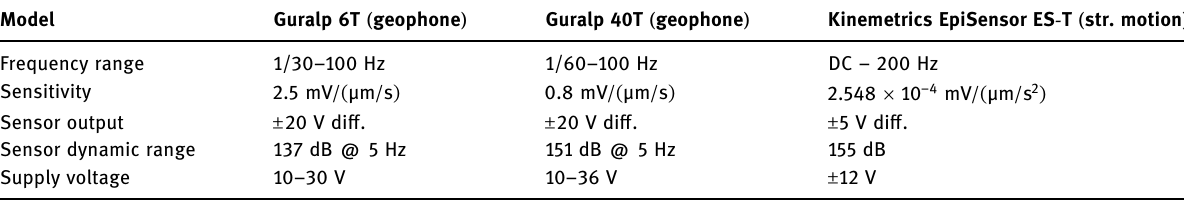
Table 1: Sensor parameters Model